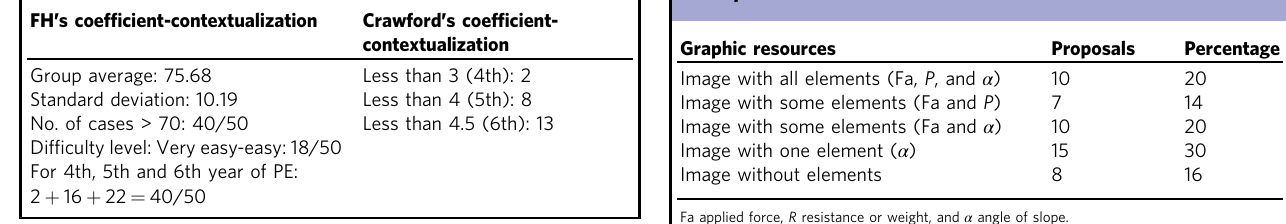
Table 5 Contextualization reading ease. Table 6 Representations of the ramp in the scripts